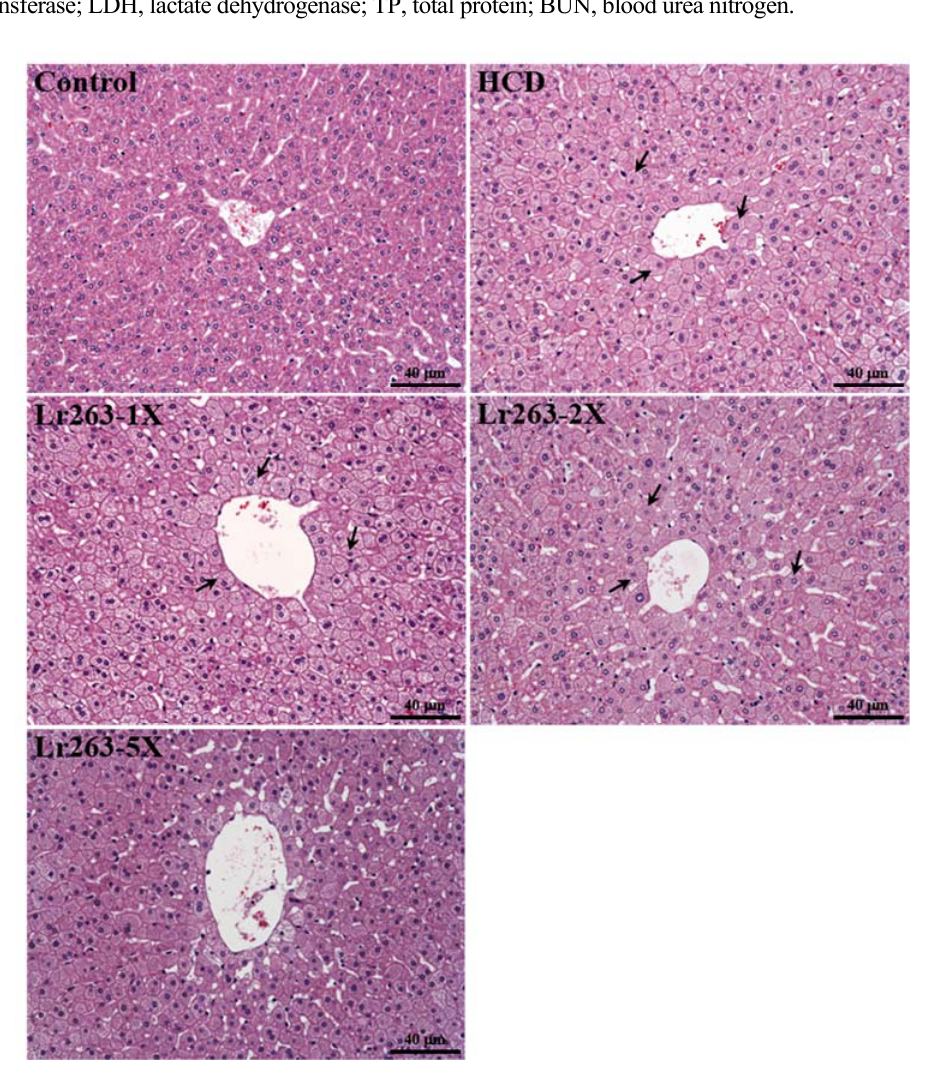
Figure 7. Effect of six-week supplementation with Lr263 on morphology of liver tissues in hyperlipidemic hamsters. Arrows indicate fat droplets. Specimens were photographed by light microscopy. (H & E stain, magnification: ×200, Scale bar, 40 μ